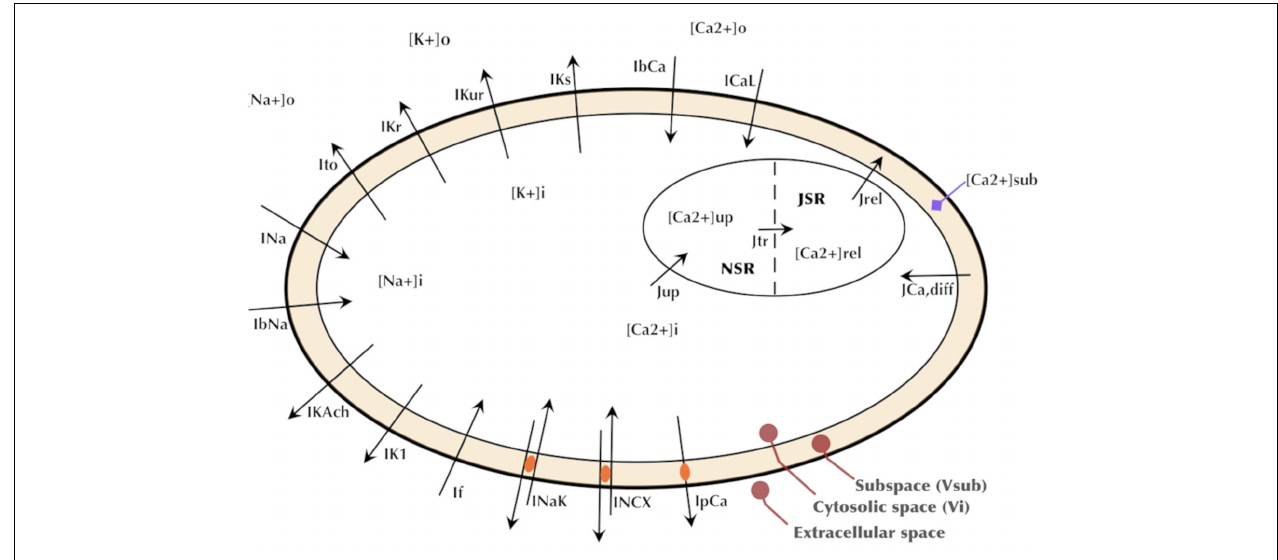
FIGURE 2 | Schematic of the hiPSC-CM model depicting the major ionic currents and fluxes.